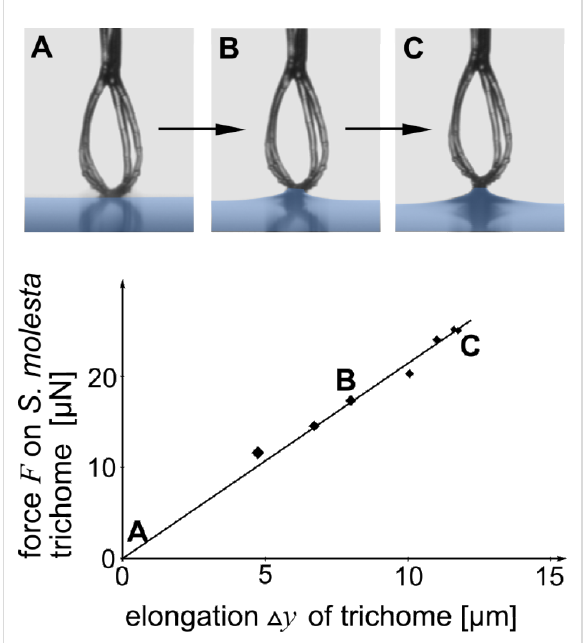
Figure 3: Force–elongation curve of a Salvinia molesta trichome. CAT allows force–elongation curves of small elastic structures to be measured based on the evaluation of the meniscus at different stages of the experiment. The linear fit to the data illustrates that the deforma- tion follows Hooke’s law quite well: before snap-off, the elongation of the trichome shows a linear force dependence. The systematic error